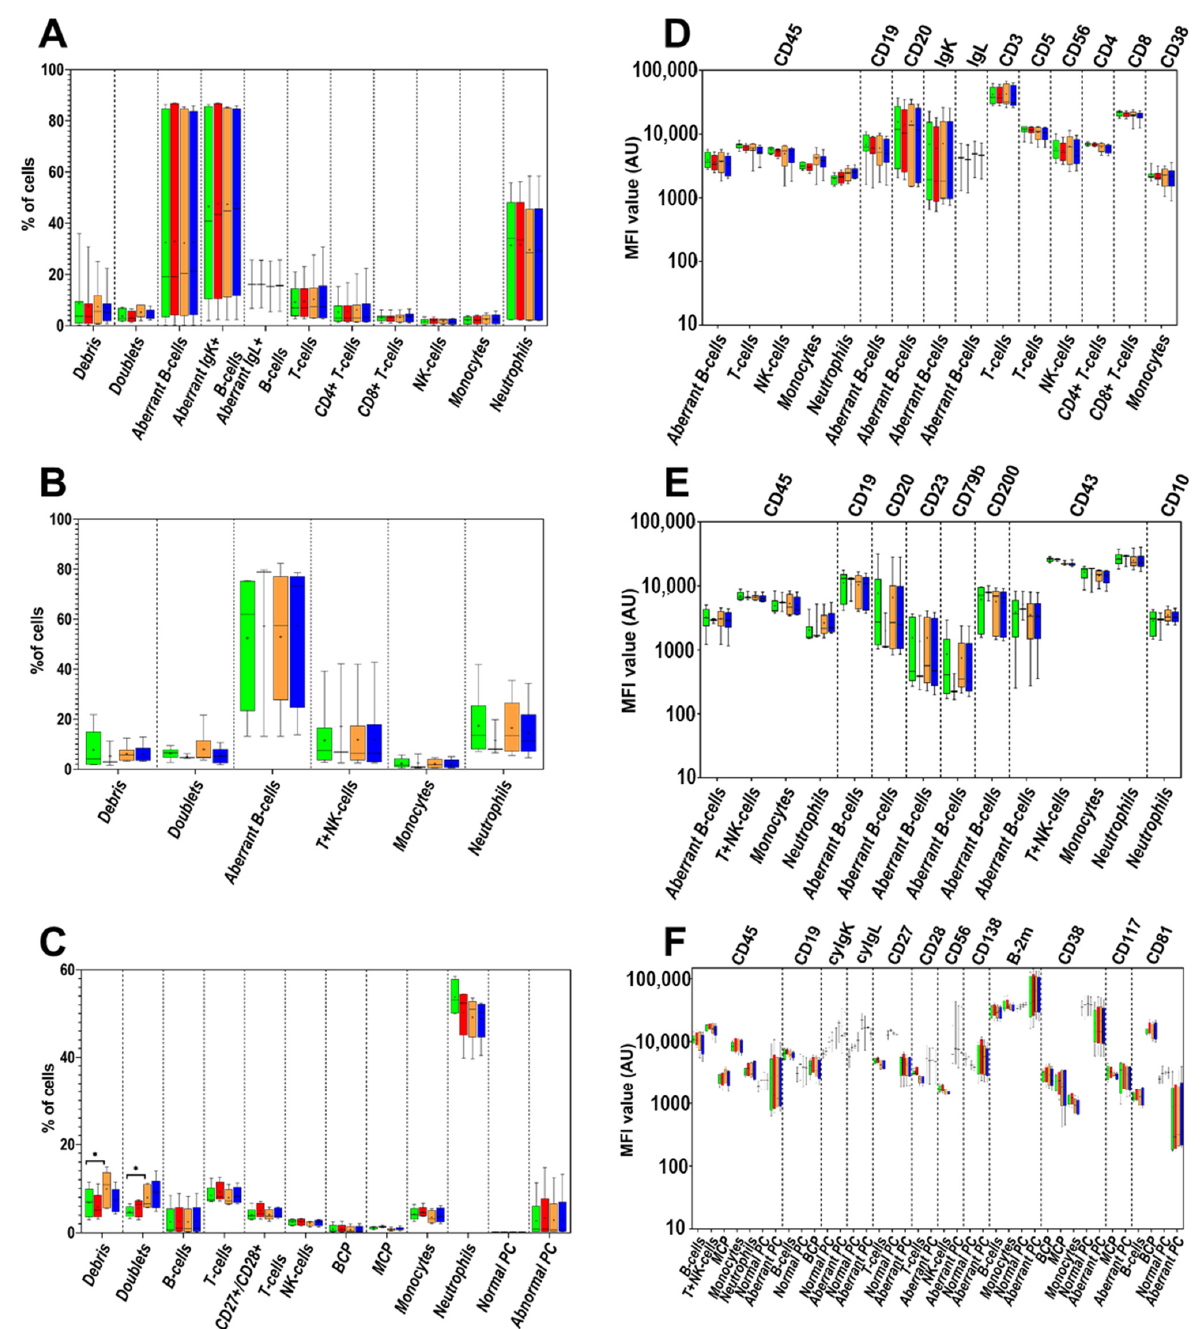
Figure 3. Comparison of the relative distribution of aberrant (clonal) B- and plasma cells and normal cell populations identifiable with the LST ( n = 13; A ), B-CLPD tube 1 ( n = 6; B ) and PCD antibody combination ( n = 10; C ) and the MFI values of individual markers expressed by aberrant and normal cells stained with LST ( D ), B-CLPD tube 1 ( E ) and the PCD antibody combination ( F ). The samples were acquired at different time points: within 15 min after staining (green boxes), after 3-h storage at 4 ◦ C (red boxes), stored overnight at RT, stained at +24 h from collection and acquired within 15 min after staining (orange boxes) or after 3-h storage at 4 ◦ C (dark blue boxes). The median and mean MFI values are indicated inside the boxes with a line and “+” sign, respectively. The boxes spread between first and third quartile of the obtained MFI values and whiskers span between minimal and maximal values. Asterisks indicate significant differences between particular time points ( p <